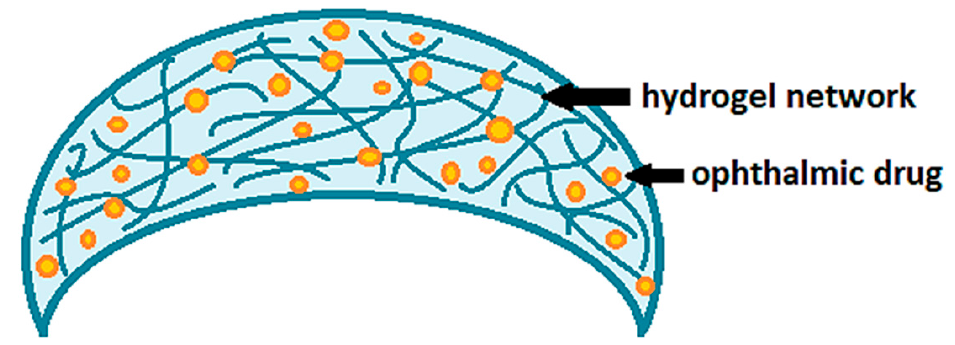
Figure 2. Drug-loaded soft contact lenses based on hydrogels.